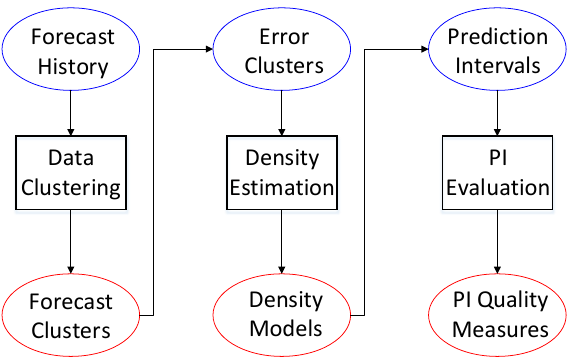
Figure 1. The process of uncertainty modeling for PI computation and evaluation-clustering based